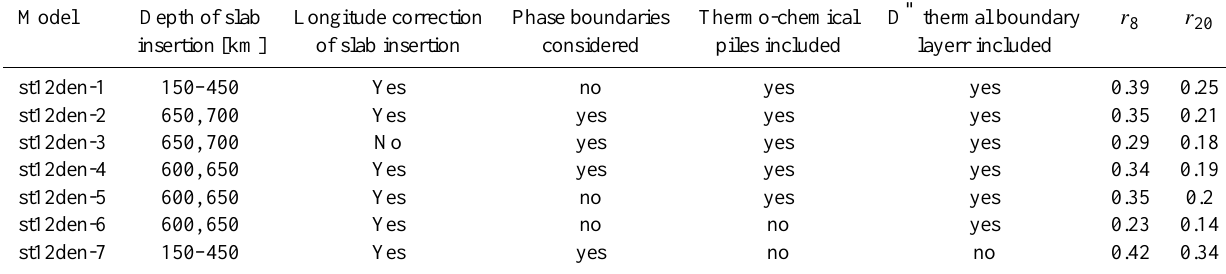
Table 1. Summary of model runs. Model Depth of slab Longitude correction Phase boundaries Thermo-chemical of slab insertion considered piles included layerr